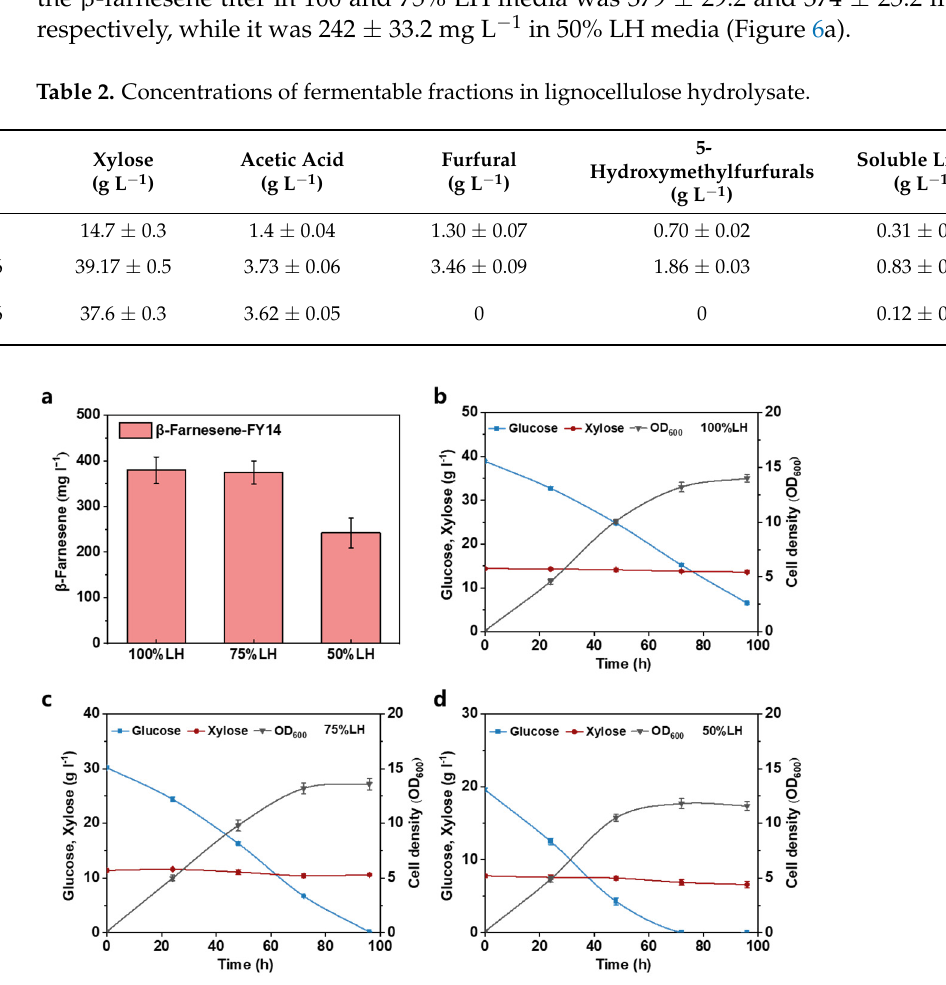
Table 2. Concentrations of fermentable fractions in lignocellulose hydrolysate.